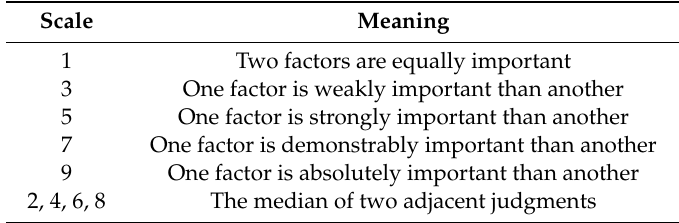
Table 1. Comparative important scale of criteria.